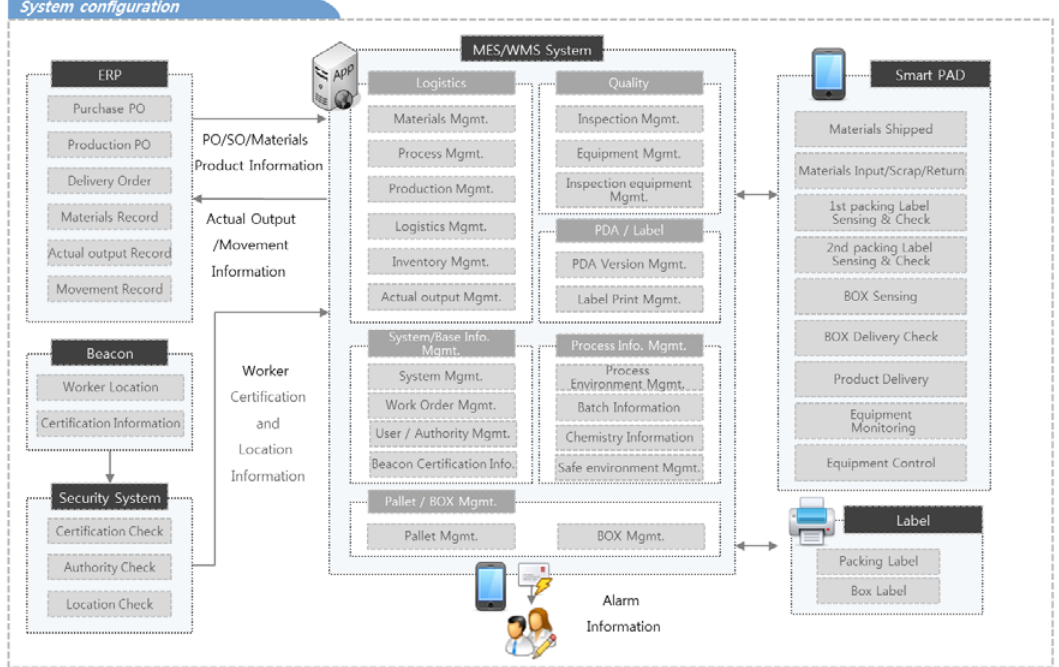
Figure 21. System Configuration of the Smart Factory Using Smart PAD.